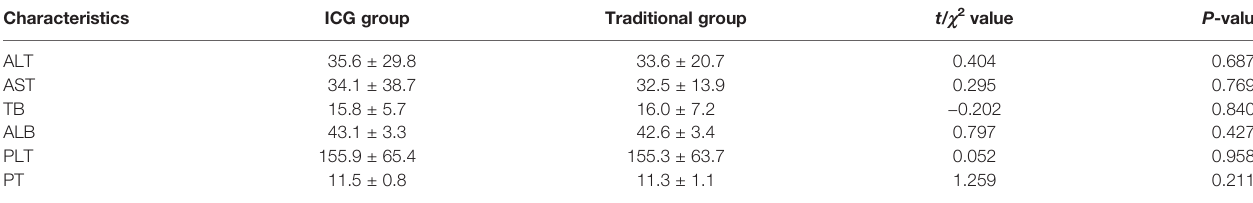
TABLE 2 | Preoperative liver function index between the ICG-guided and traditional groups.